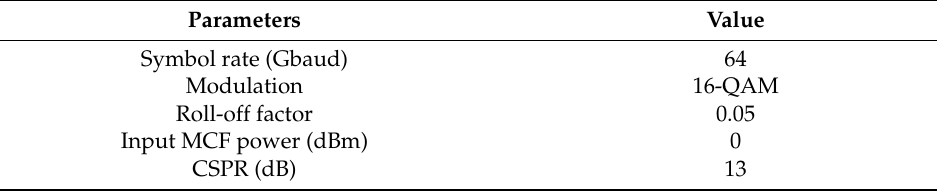
Table 1. Signal parameters.